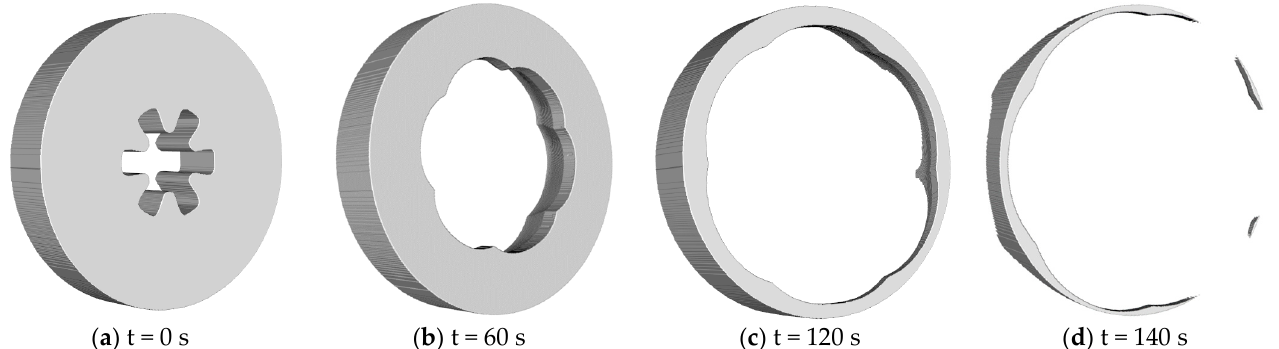
Figure 12. The burning process of star grain under erosive burning.